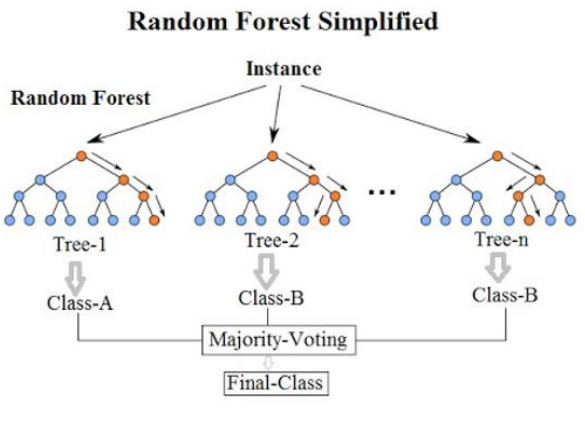
Figure 1: Performance of the Random Forest